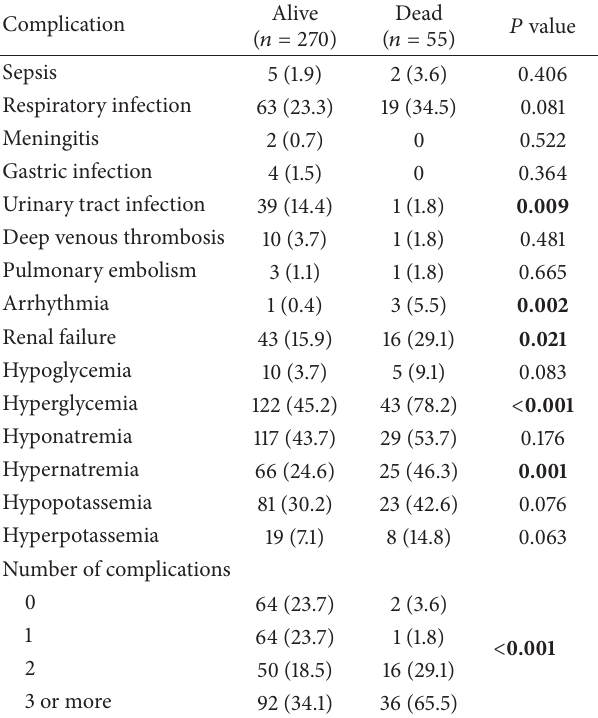
Table 3: Univariate analysis of in-hospital complications on 3- month mortality in young patients with intracerebral hemorrhage.